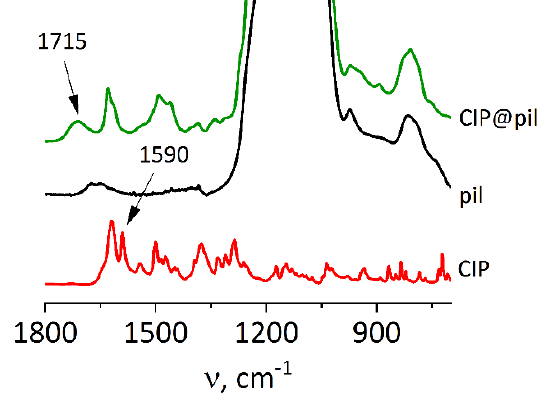
Figure 6. FT-IR spectra for pillared (pil) ZSM-55 intercalated with ciprofloxacin (CIP). Zeolite spectra normalized to 1090 cm − 1 band (Si-O-Si vibrations), ciprofloxacin normalized to the content in composite. Alternative representations of the data are available in supplementary material (Figure S2).